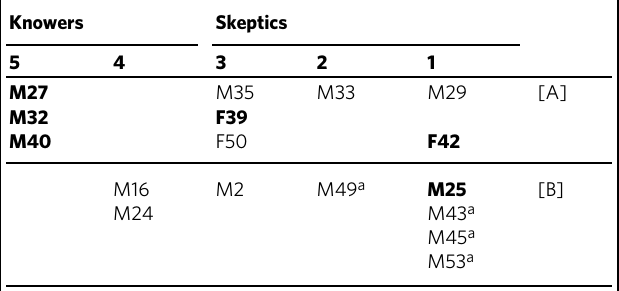
Table 3 Subjects objectively